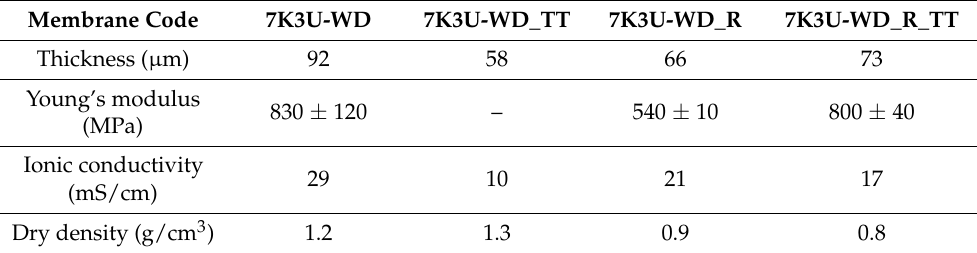
Table 5. Fully hydrated thickness, Young’s Modulus, ionic conductivity and dry density of 7K3U-WD